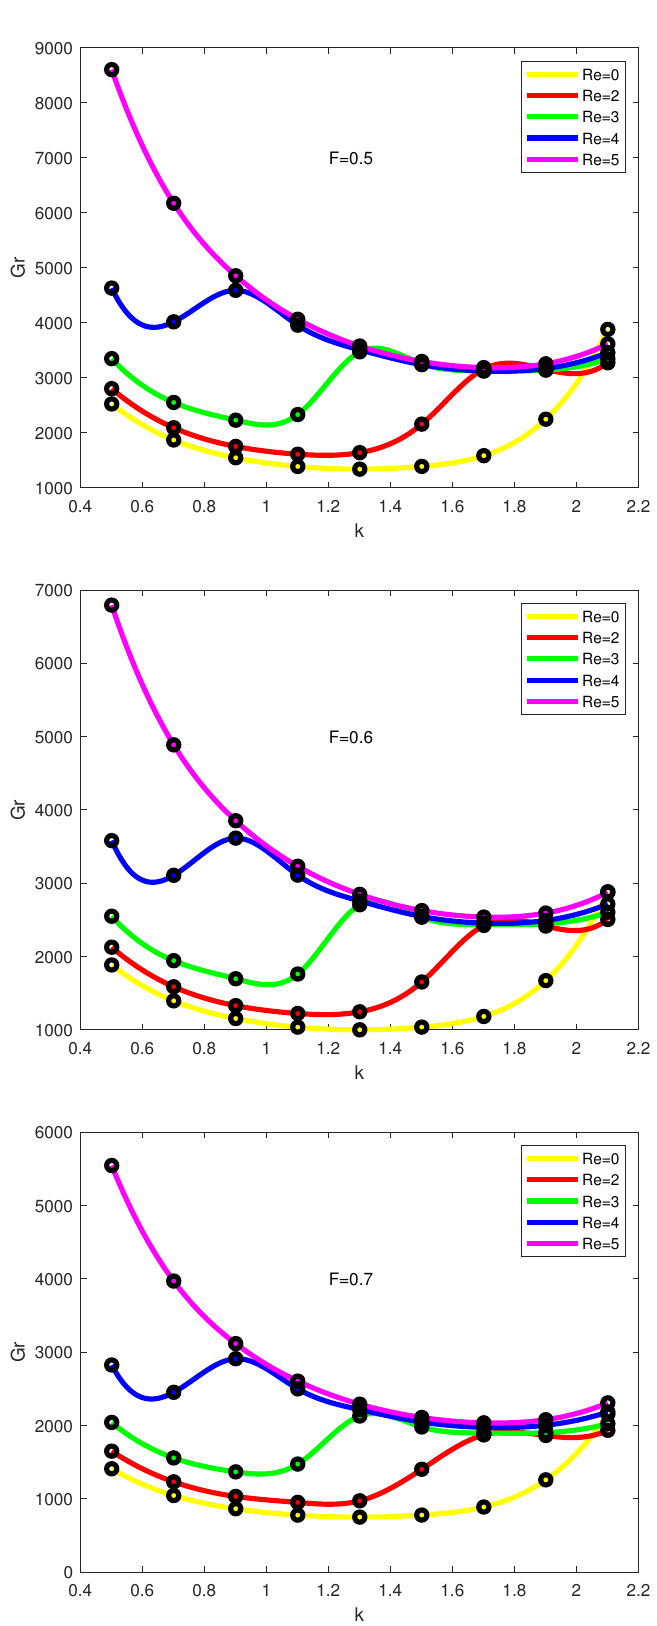
Figure 3. Marginal stability curves for different values of F and Re